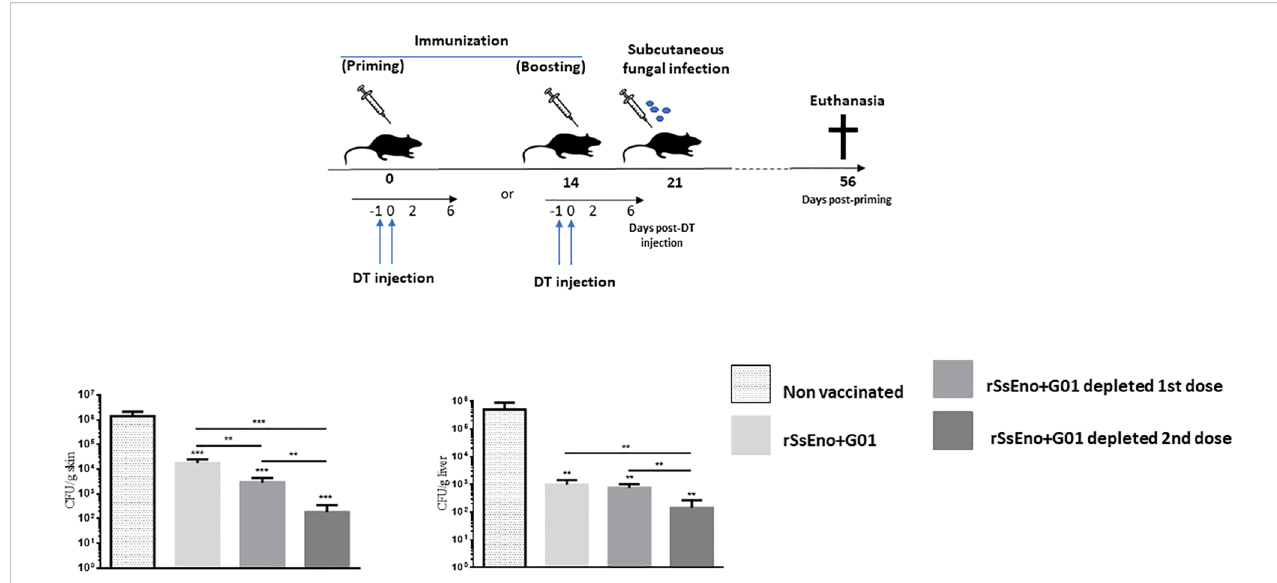
FIGURE 4 Tregs-depletion during boost immunization confers enhanced protection against a challenge with S. brasiliensis conidia compared with non-depleted Tregs vaccinated mice and those depleted during the prime vaccination. To analyze the effect of Tregs depletion on protection against the fungal infection in vaccinated mice, wild-type littermates and DEREG mice were immunized on days 0 and 14 with a recombinant-based vaccine against Sporothrix spp. On days -1, and 0, all mice were treated with DT. At day 21 post priming all mice were challenged with 1 x10 7 conidia by subcutaneous injection. The resulting fungal load was monitored at 56 days post-priming at the site of inoculation and in the liver (local and systemic dissemination respectively). This experiment was repeated twice with similar results. **(p < 0.01); ***(p <